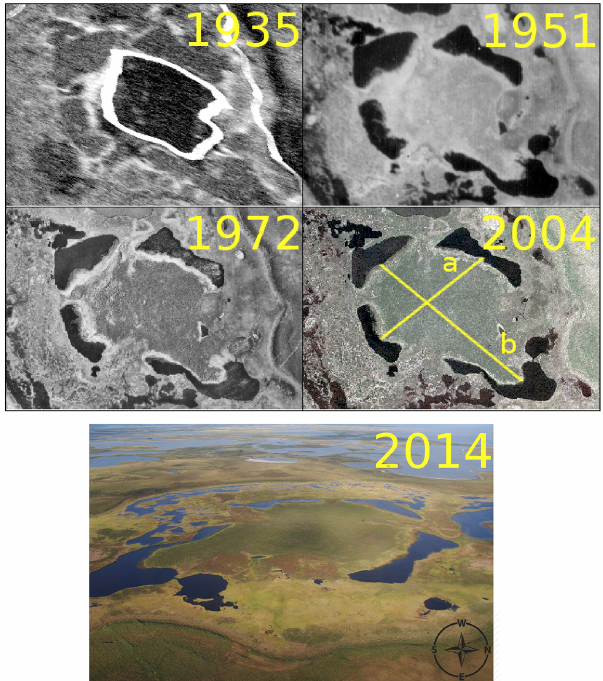
Figure 4. (Top) Historical aerial photographs of study site (National Air Photo Library, Natural Resources Canada) from 1935, 1950, 1972, and 2004 showing that the study site was occupied by a pond in 1935. For reference length of a is 560m and length of b is 770m. (Bottom) Photograph of study site taken in August 2014 from heli- copter (viewing from